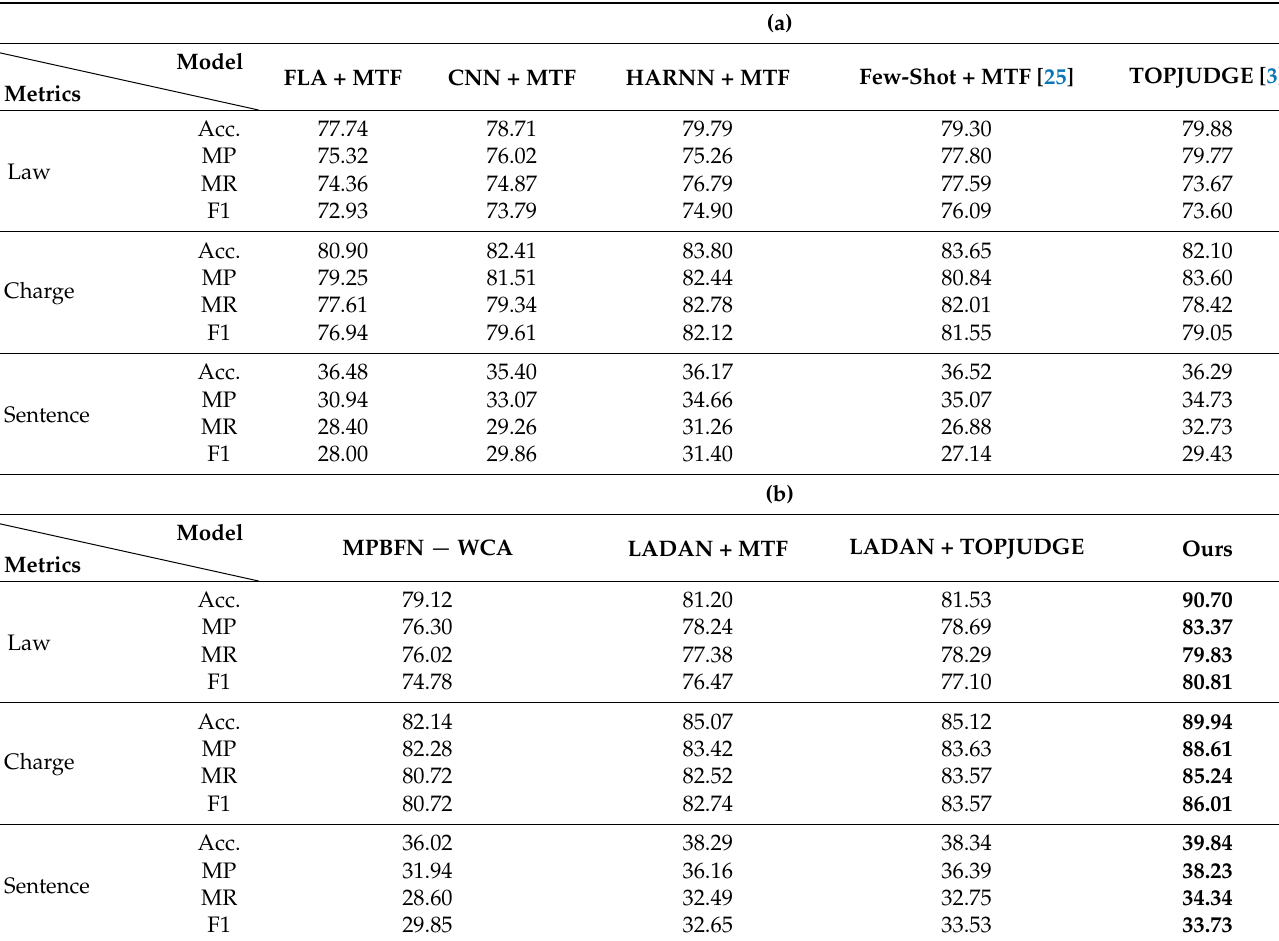
Table 5. Results of judgment prediction on CAIL-small in comparative experiments (%) (a) and (b).